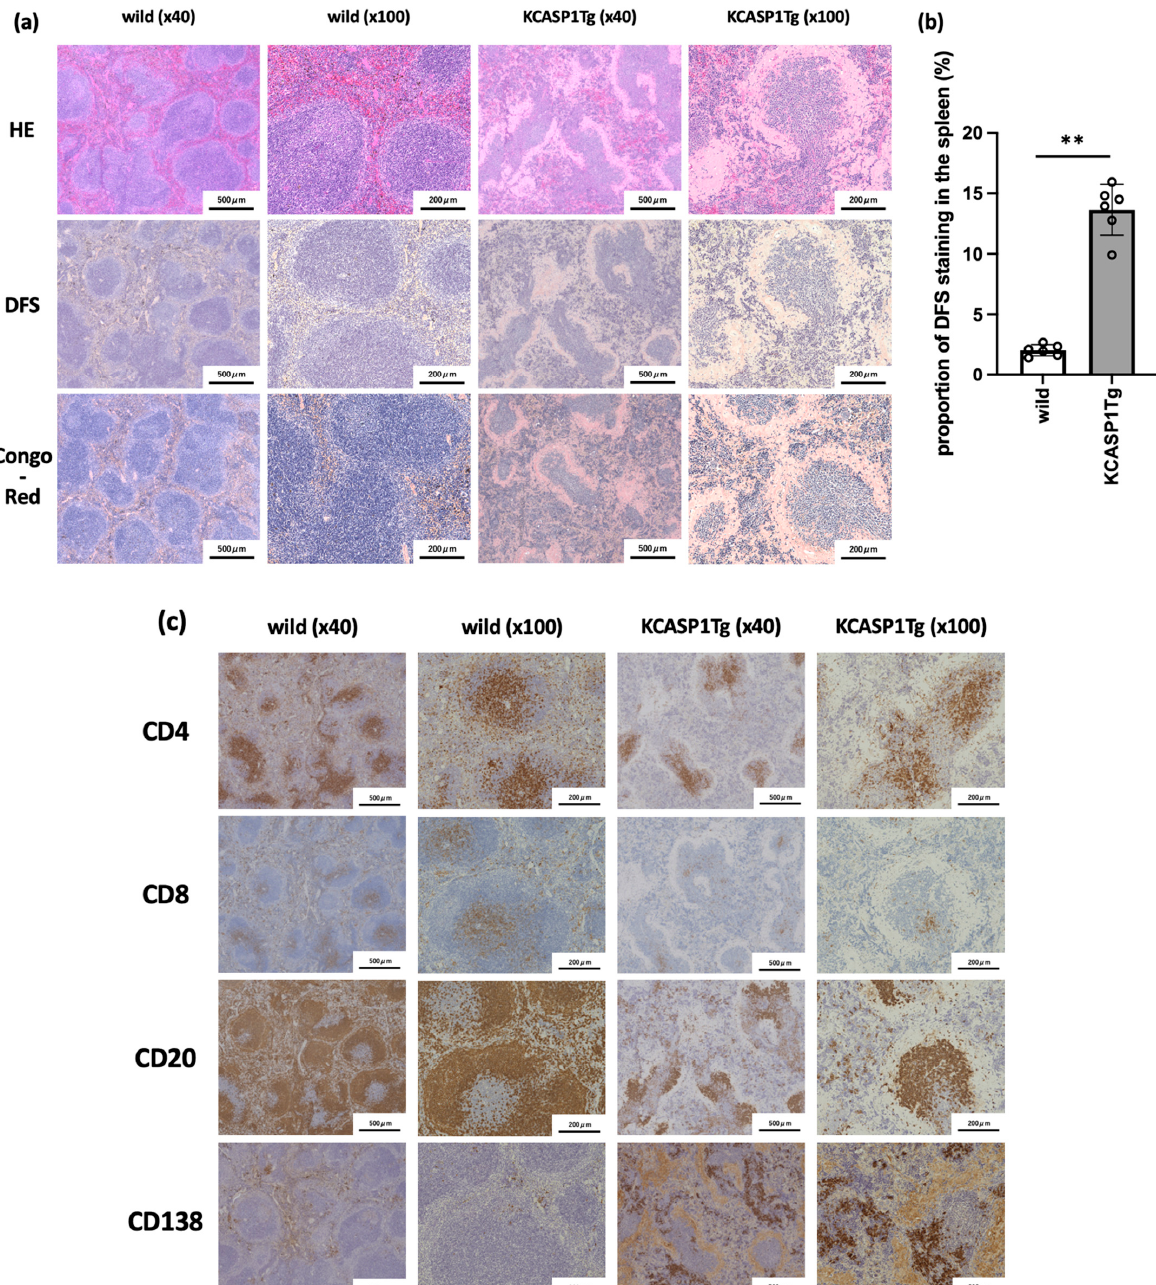
CD4, CD8, and CD20 in the entire spleen decreased in KCASP1Tg mice. In addition, the counts per weight of spleen (count/g of each spleen) decreased in KCASP1Tg mice.